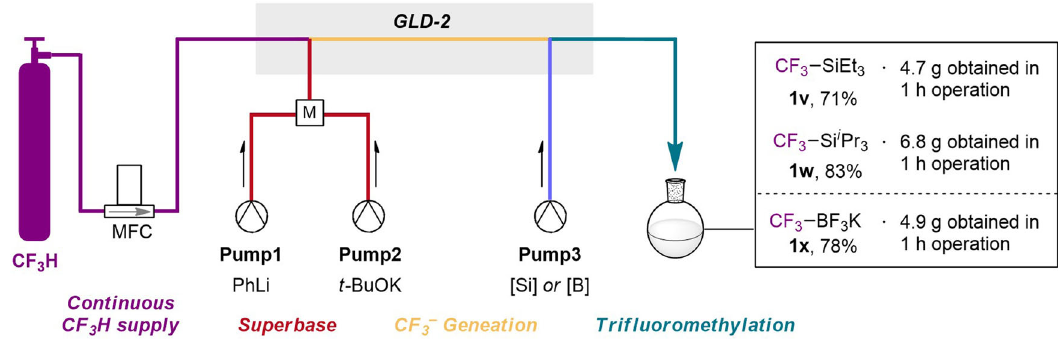
Fig. 5 | The multi-gram-scale synthesis. One- fl ow multi-gram synthesis using an integrated fl ow system involving